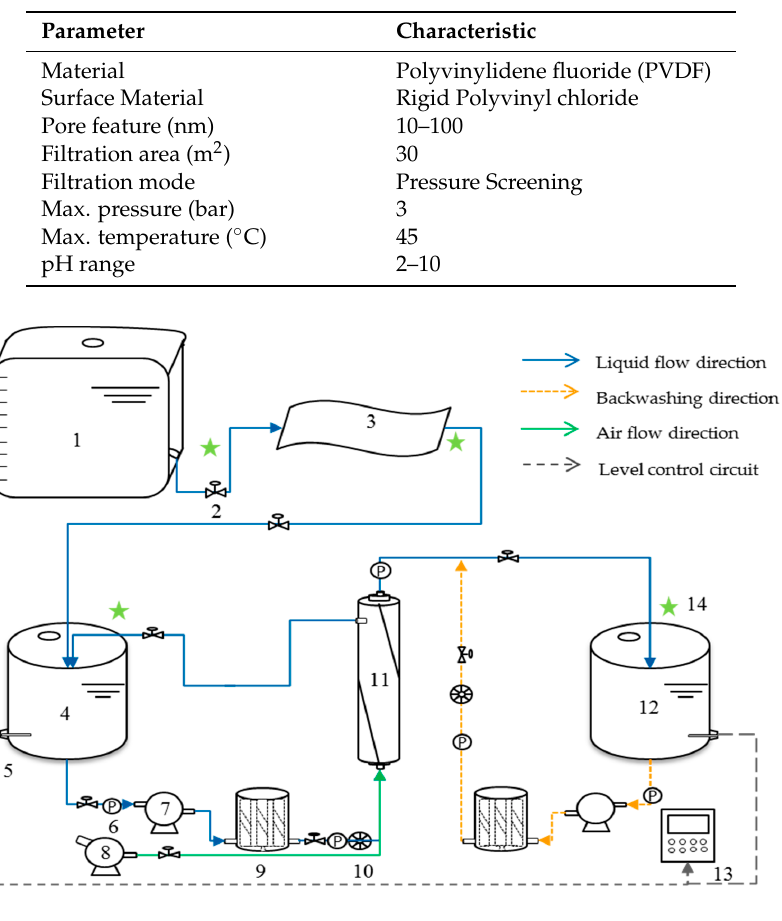
Figure 1. Schematic diagram of the combined process of paper filtration and hollow fiber